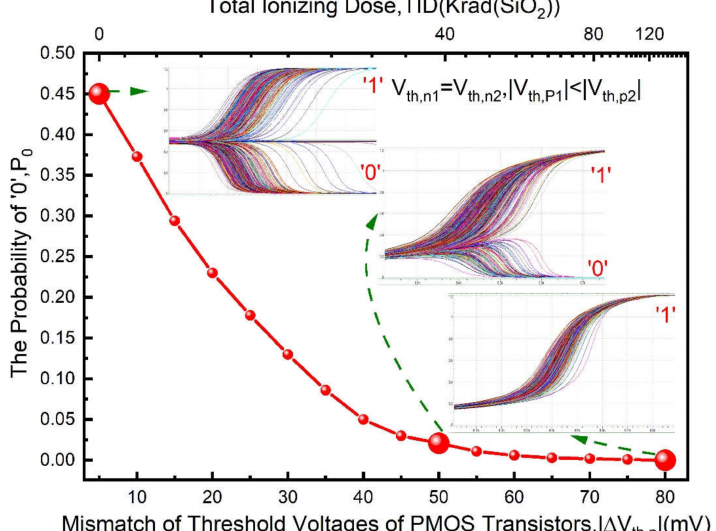
Figure 5. Simulation results for a strong cell ( dose increases.